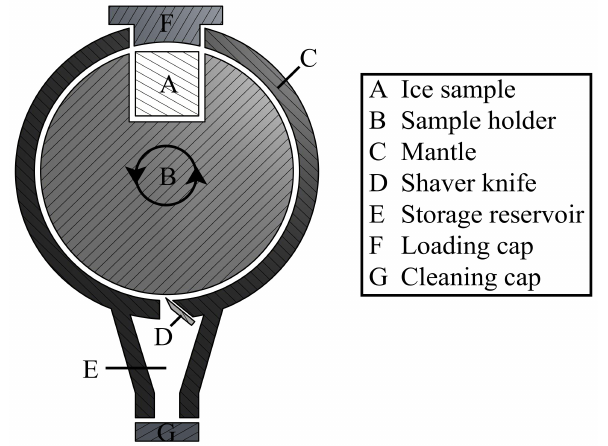
Fig. 1. Schematic illustration of the CIM for extracting enclosed air in ice under dry conditions. The legend and letters mark the different parts of the device including the sample (A). The sample holder (B) can be rotated within the mantle (C) as indicated by the arrows (tol- erance between A and C: 1mm). Access to load the sample holder is provided via the upper cap (F) and to remove the ice powder from the storage reservoir (E) via the lower cap